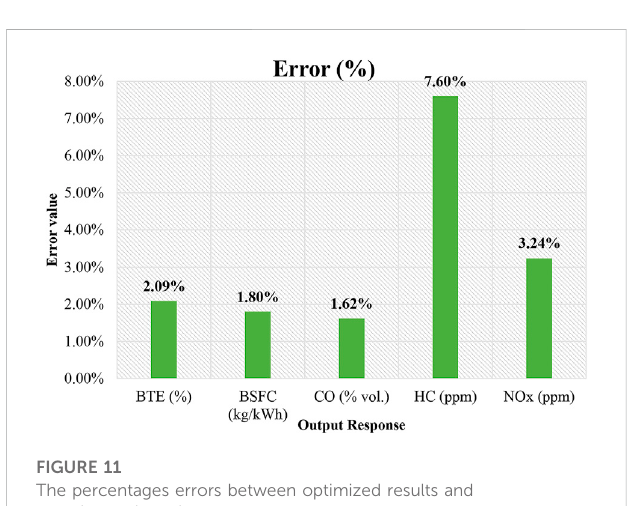
FIGURE 11 The percentages errors between optimized results and experimental